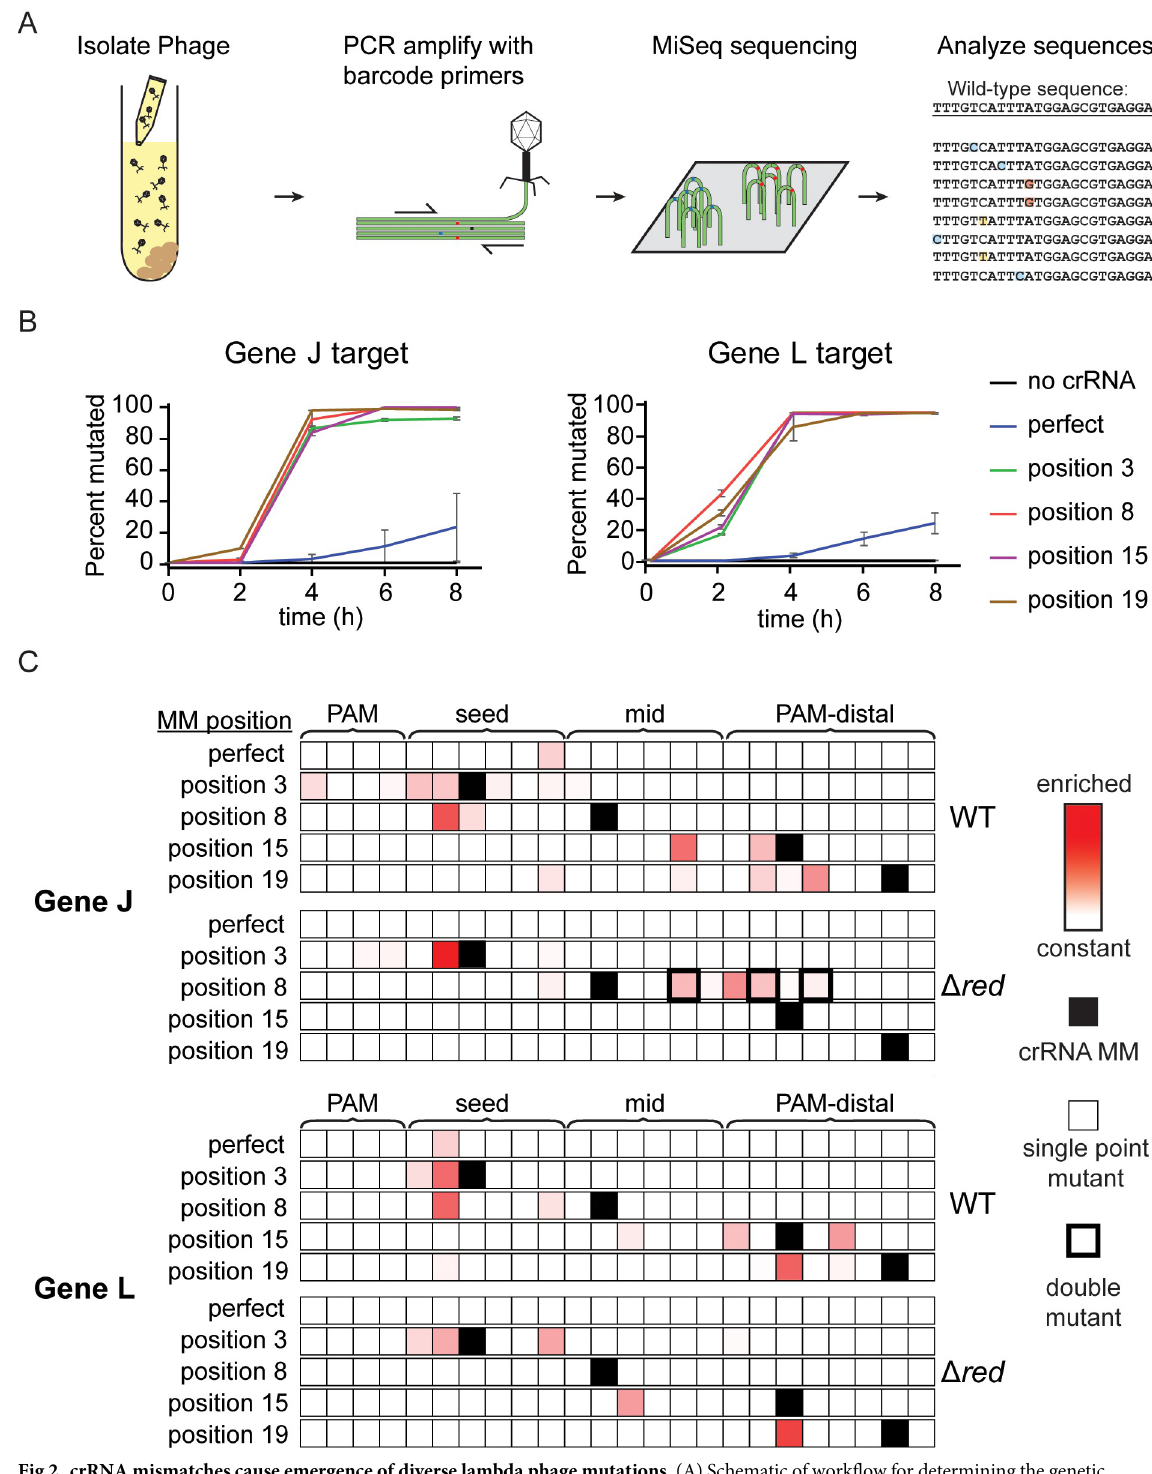
Fig 2. crRNA mismatches cause emergence of diverse lambda phage mutations. (A) Schematic of workflow for determining the genetic diversity of phage exposed to interference by Cas12a. Phage samples were collected from liquid cultures at various time points and the target region was PCR amplified. Mutations were observed using MiSeq high-throughput sequencing of these amplicons. (B) Line graph tracking the fraction of phage with mutated target sequences over time. Samples were taken from liquid cultures at time points after phage infection. The “0 h” samples were taken directly after addition of phage to the culture tubes. The average of 2 replicates are plotted with error bars representing